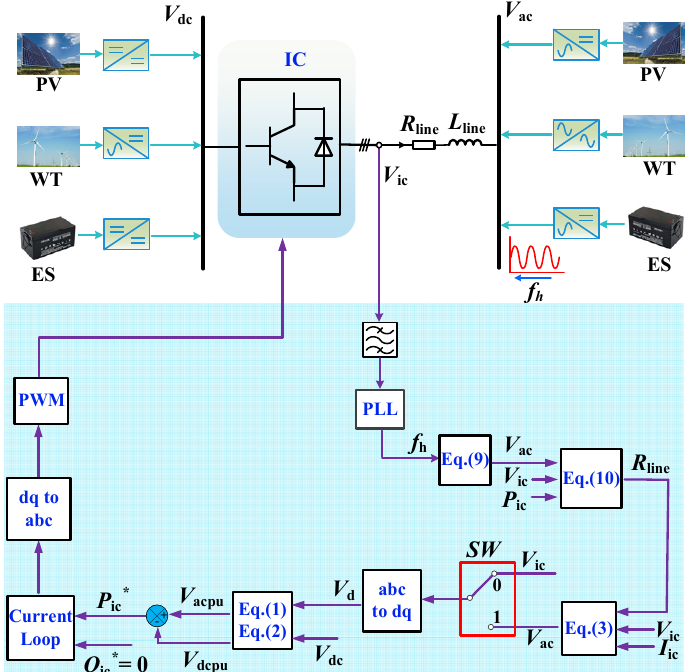
Figure 4. Control strategy of the IC based on line impendence compensation.